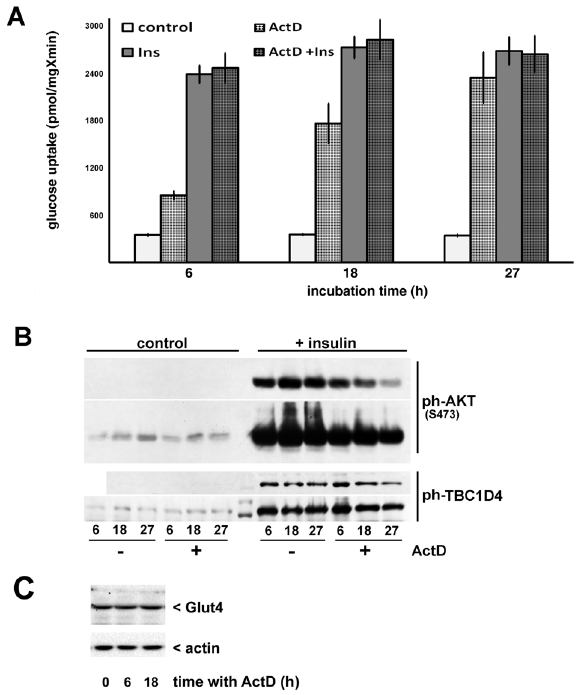
Figure 1. Actinomycin D increases glucose uptake in adipocytes without engaging the insulin signaling pathway. ActD (5 µM) was added to differentiated 3T3-L1 adipocytes for the indicated amount of time and cells were assayed for glucose uptake in the absence and in the presence of insulin (Panel A ) or analyzed by Western blotting (Panels B and C ). The error bars represent standard deviations. Panel B shows two different